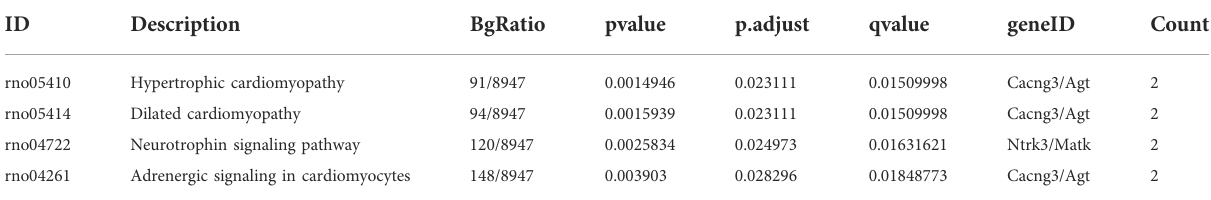
TABLE 2 KEGG enrichment